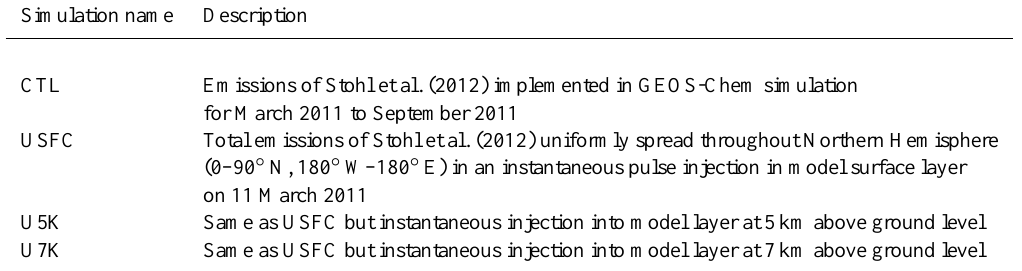
Table 1. Summary of the simulations conducted for this study.